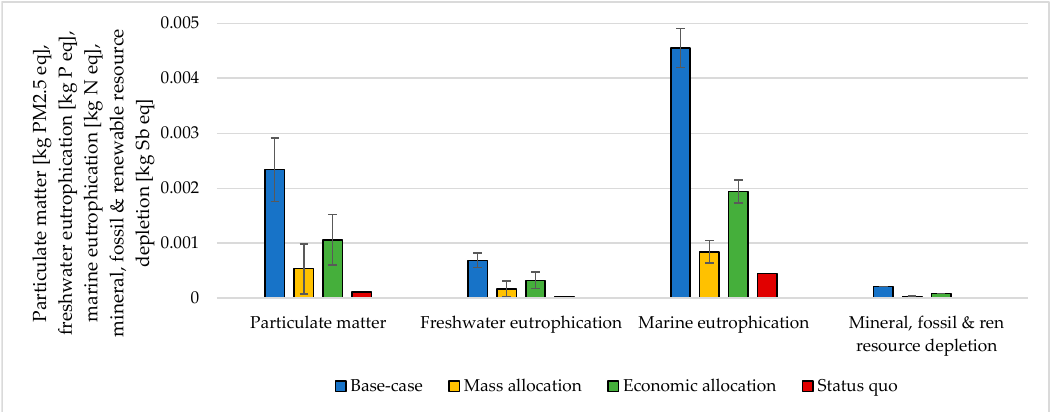
Figure 8. Particulate matter, freshwater eutrophication, marine eutrophication, and resource depletion assessment for 1 kg SNG production under different MU methodologies: base-case, mass allocation, economic allocation, and status quo.